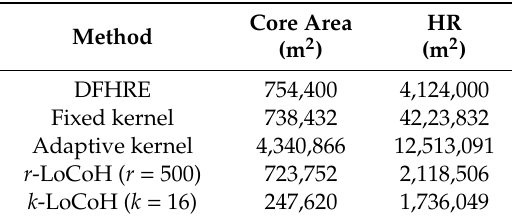
Figure 13. HRs estimated by the kernel density-based estimator (KDE) methods for Dataset 1. Table 1. Sizes of the core areas and HRs estimated by the DFHRE, KDE and LoCoH methods for Dataset 1.